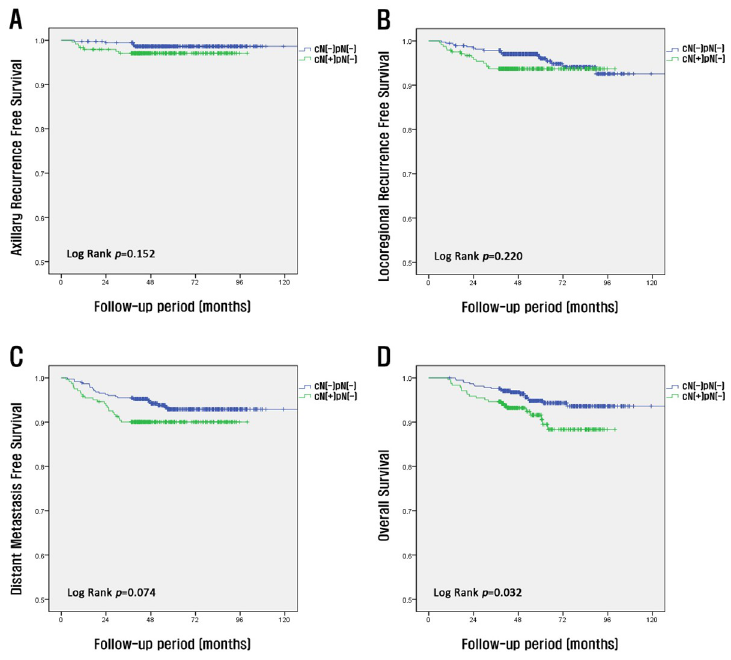
Fig 2. Kaplan–Meier curves according to clinical node status in patients with pathologically negative nodes (-). Axillary recurrence-free survival (A), locoregional recurrence-free survival (B), distant metastasis-free survival (C), and overall survival (D).